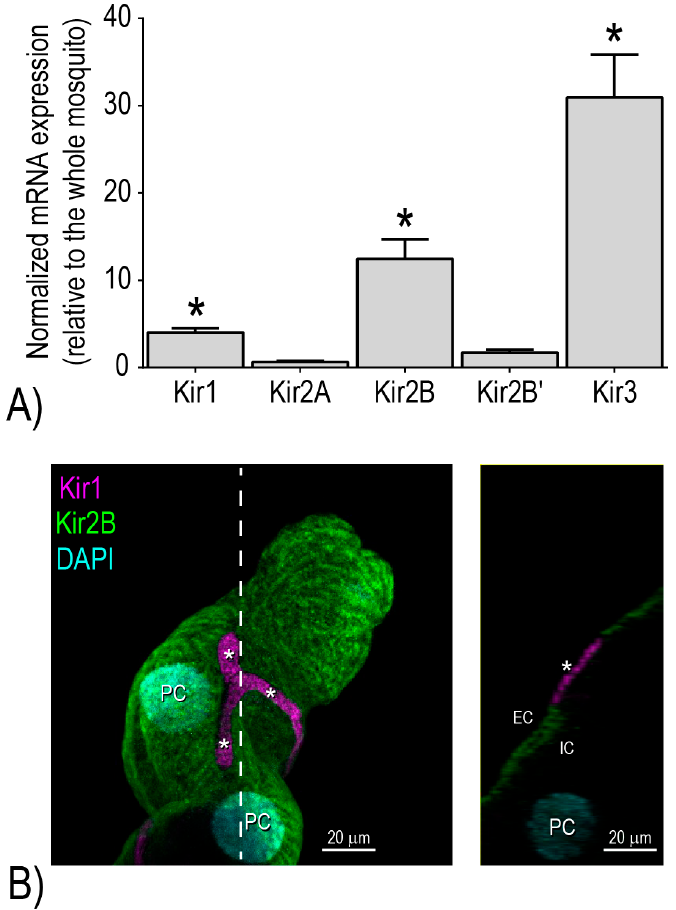
Figure 3. Molecular and immunochemical expression of Kir channel subunits in Malpighian tubules of adult female Ae. aegypti . ( A ) Relative mRNA expression of Kir subunits in Malpighian tubules normalized to expression in the whole mosquito. Values are means ± SEM. Asterisks indicate significantly enriched mRNA expression in the Malpighian tubules vs. the whole mosquito ( P < 0.05). Data are from [22]. ( B ) Immunolocalization of Ae Kir1 (magenta) and Ae Kir2B (green) in Malpighian tubules. The left panel shows the cell-specific localization of Ae Kir1 to stellate cells (asterisks) and Ae Kir2B to principal cells. The right panel shows an optical section through the tubule in the plane indicated by the dashed line. Note the immunolabeling occurs along the basolateral region of each cell type. “EC” indicates extracellular space; “IC” indicates intracellular space; “PC” indicates nuclei of principal cells. Modified from [17] with permission.